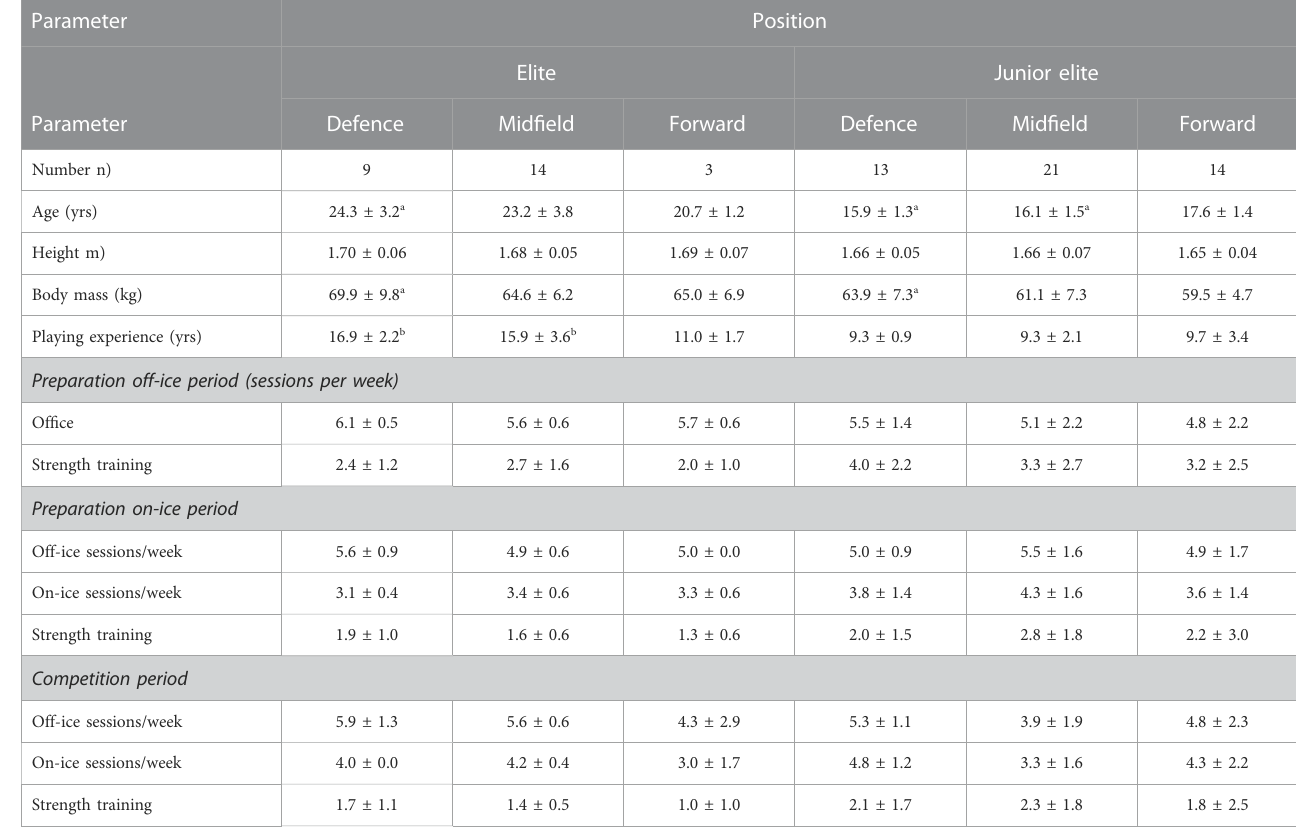
TABLE 1 Mean (±SD) anthropometrics and training experience for each playing position and level.